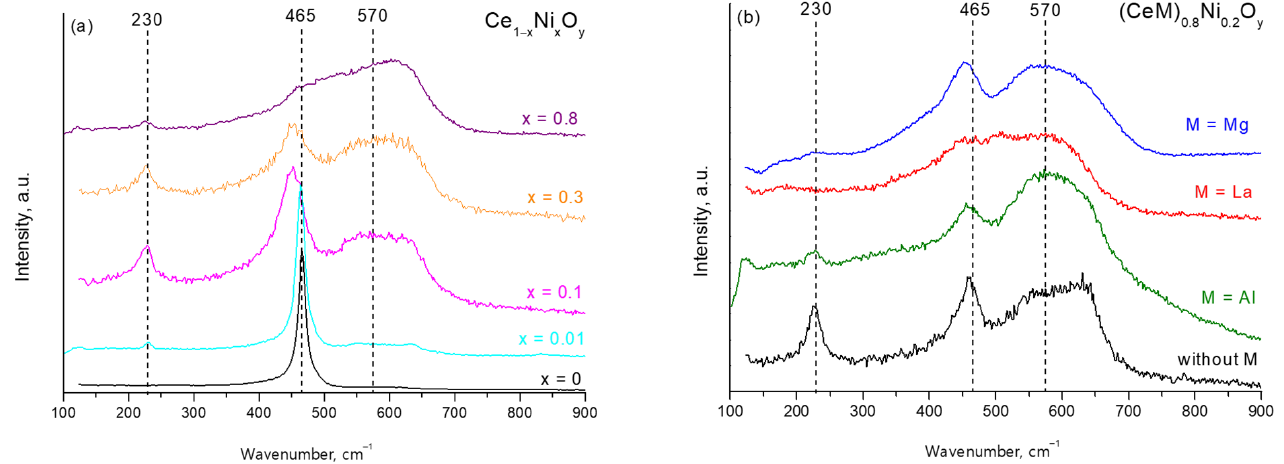
Figure 8. Raman spectra for (CeM) 1 − x Ni x O y (M = Al, La, Mg) samples: effect of Ni molar fraction ( a ) and M type ( b ). ( b )—M/Ce molar ratio is equal to 1.